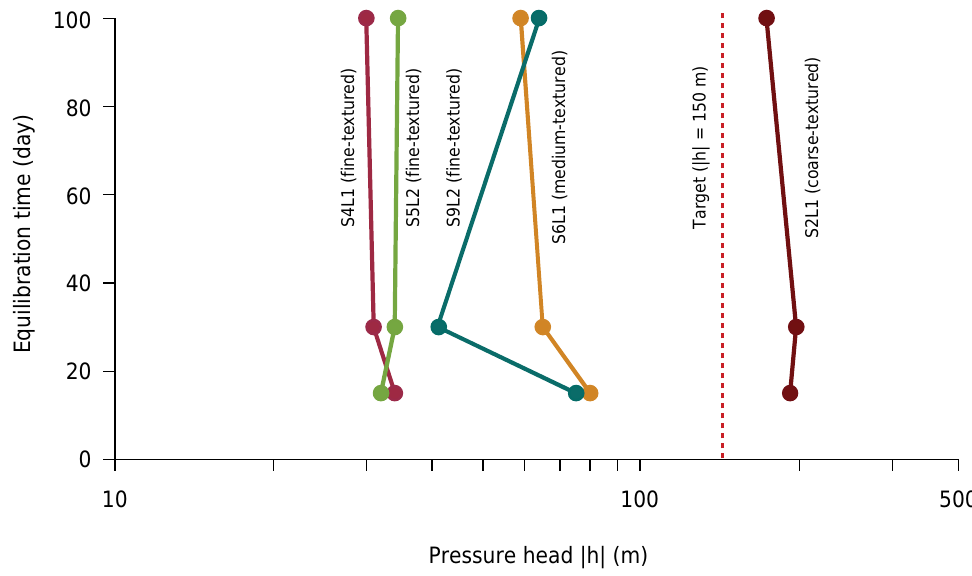
Figure 1. Pressure head measurements performed by the dewpoint device on soil samples allowing 15, 30, and 100 days of equilibration (open circles) in the pressure plate apparatus at pressure head -150